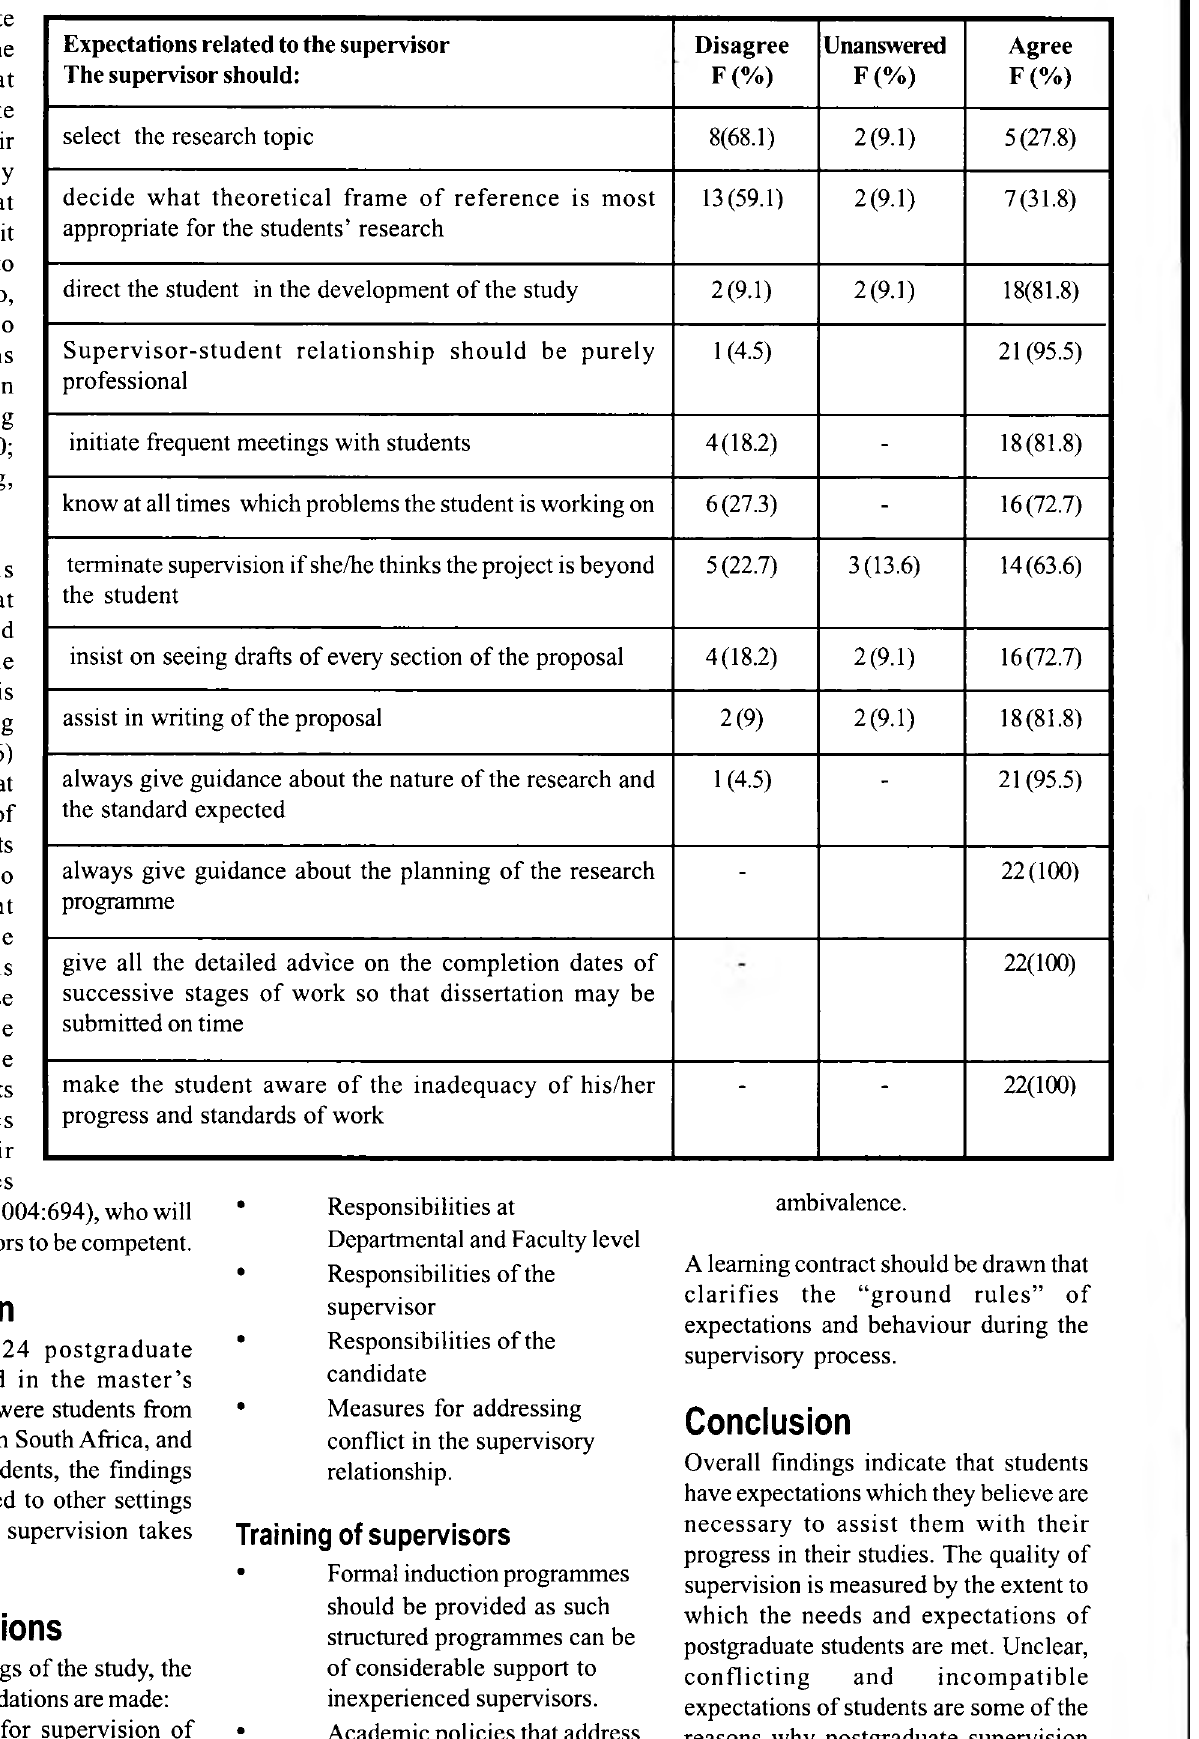
Table 4: Expectations related to the